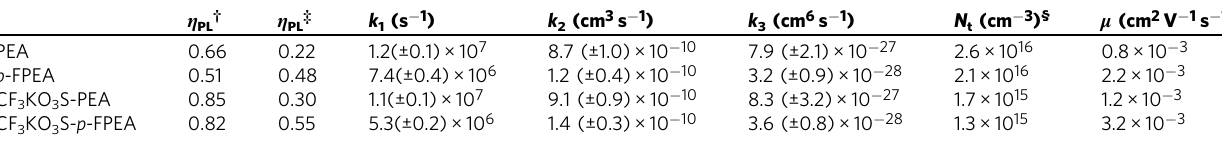
† Measured under the carrier density of ~1.2×10 15 cm − 3 . ‡ Measured under the carrier density of ~2.3×10 17 cm − 3 . § Extracted from SCLC